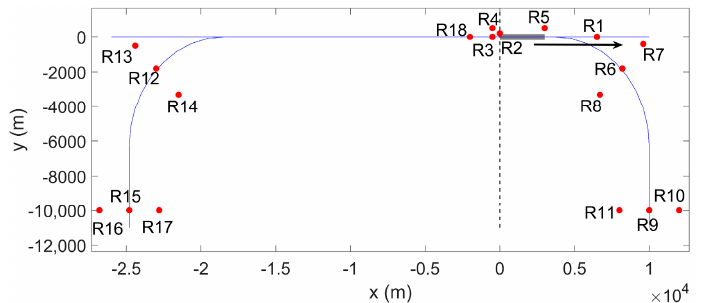
Figure A2. Departure and approach routes for reference cases, with the associated observers.